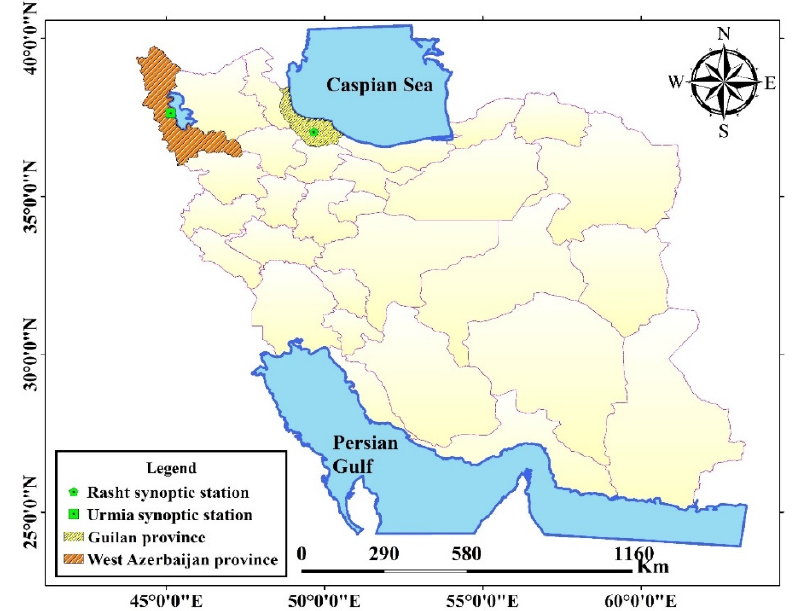
Figure 1. Geographical locations of the studied stations.